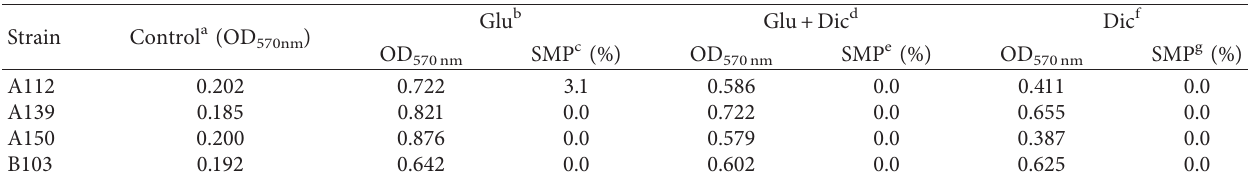
Table 3: Degree of degradation of biofilm induced by glucose and diclofenac after treatment with sodium metaperiodate in 4 strains of S. aureus